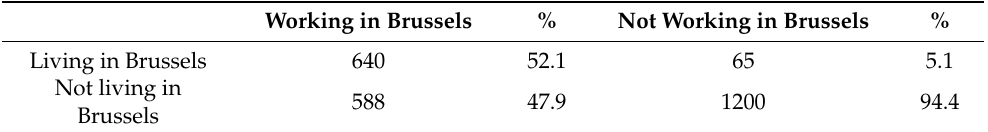
Table 2. Overlap proximities.